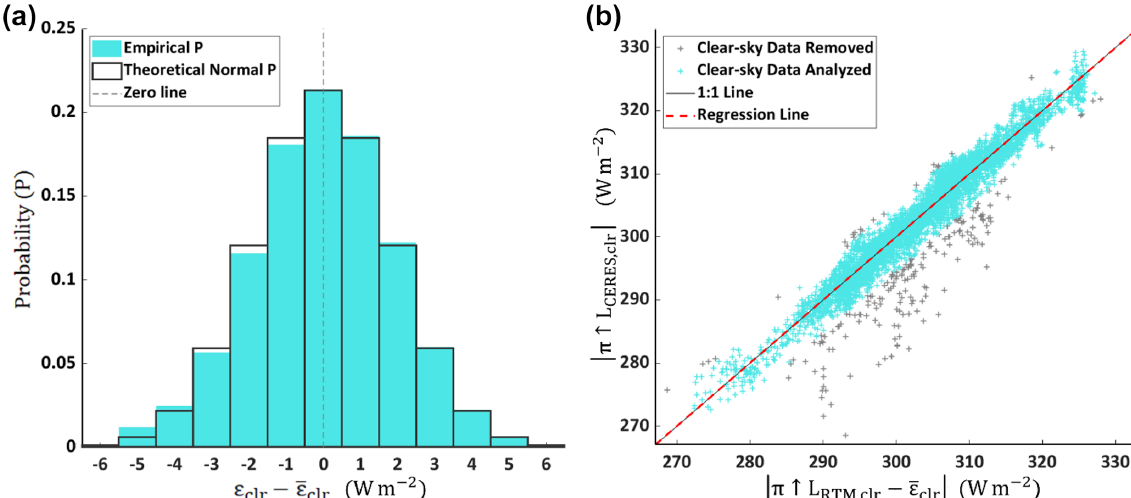
Figure 2. (a) Empirical (solid turquoise fill) and fitted theoretical normal (black lines) probability distributions of ε clr around ε clr , and (b) scatter plots of π ↑ L CERES , clr versus π ↑ L RTM , clr values shifted by ε clr in absolute sense. In Fig. 2b, the gray points show the (outlier) data points discarded based on the quartile